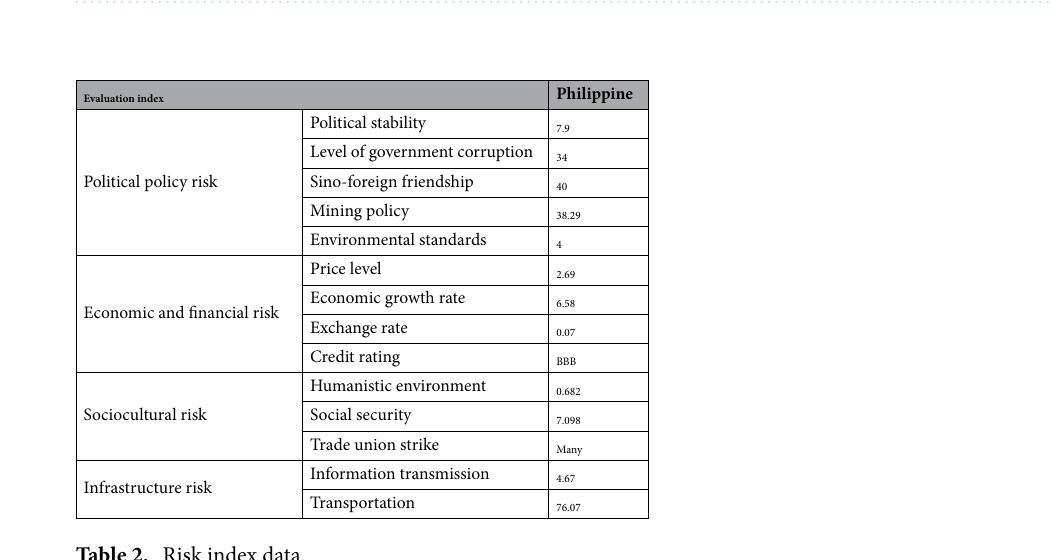
Table 1. Evaluation factors and grading standards of environmental risk for an evaluation of overseas mining investment in the Philippines.